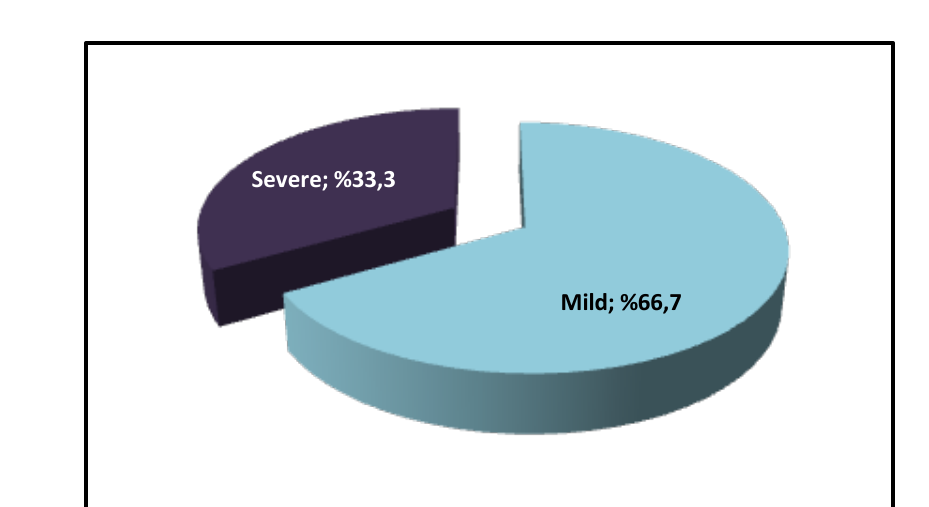
Figure 2. Severity According to the CARS Scores of Autistic Cases